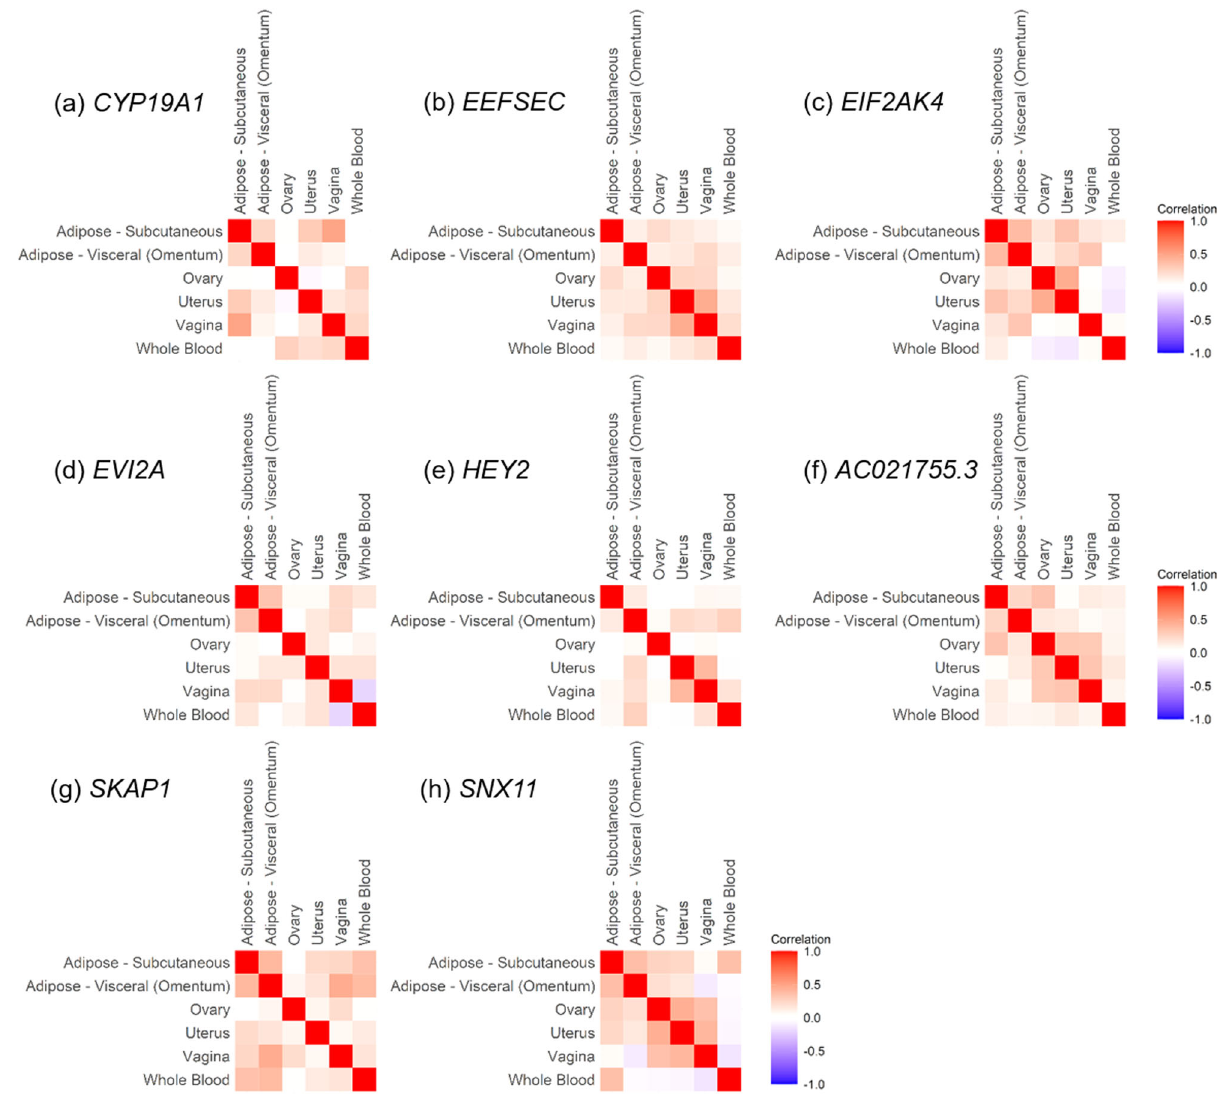
Fig. 1 Expression correlation of candidate endometrial cancer susceptibility genes between tissues. Gene expression of CYP19A1 ( a ), EEFSEC ( b ), EIF2AK4 ( c ), EVI2A ( d ), HEY2 ( e ), AC021755.3 ( f ), SKAP1 ( g ) and SNX11 ( h ) was compared across the six relevant tissues: whole blood, vagina, uterus, ovary, visceral (omentum) adipose and subcutaneous adipose (available in Supplementary Data 1). The intensity of the color shows the magnitude of the expression correlation between tissues, where intense red color indicates a strong positive correlation and intense blue color indicates a strong negative correlation.